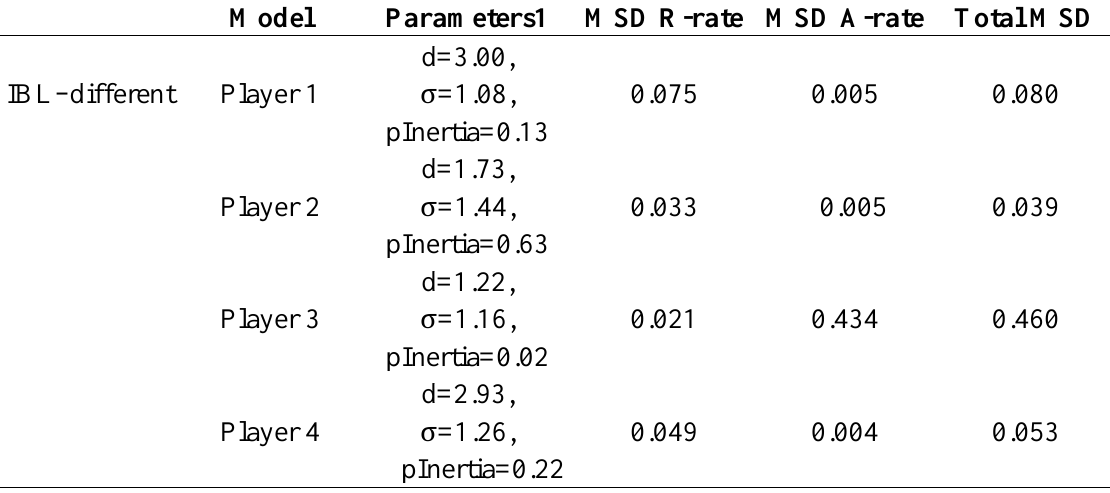
Table 3. Performance of the IBL-different and IBL-same models in the